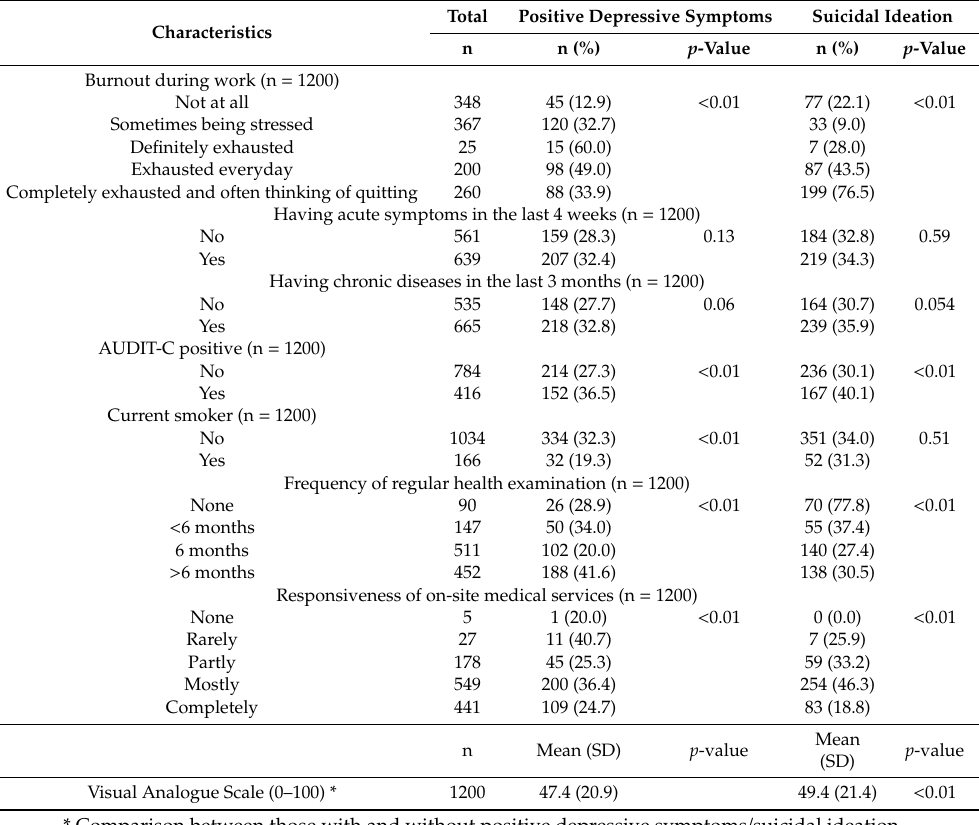
Table 2. Depressive symptoms according to health status, behaviors, and on-site health care.